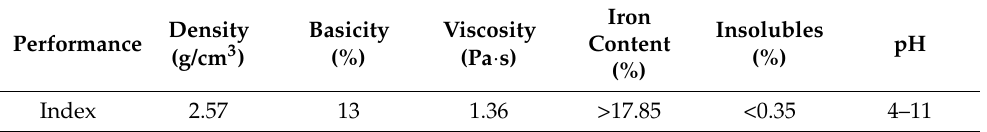
Table 3. Performance index of PTFS.